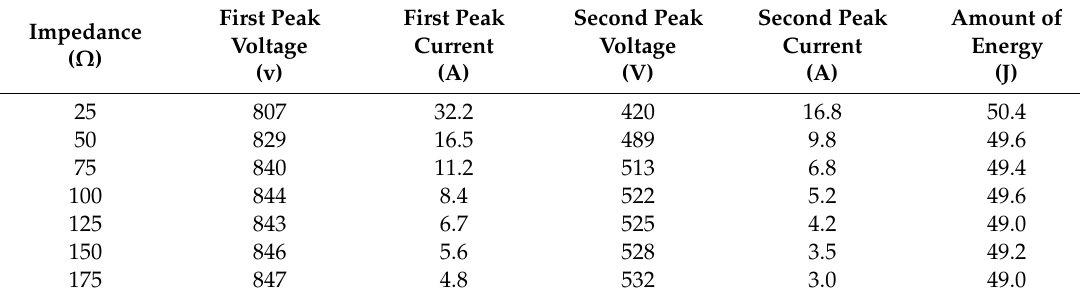
Table 3. Test result table for electric shock energy in pediatric